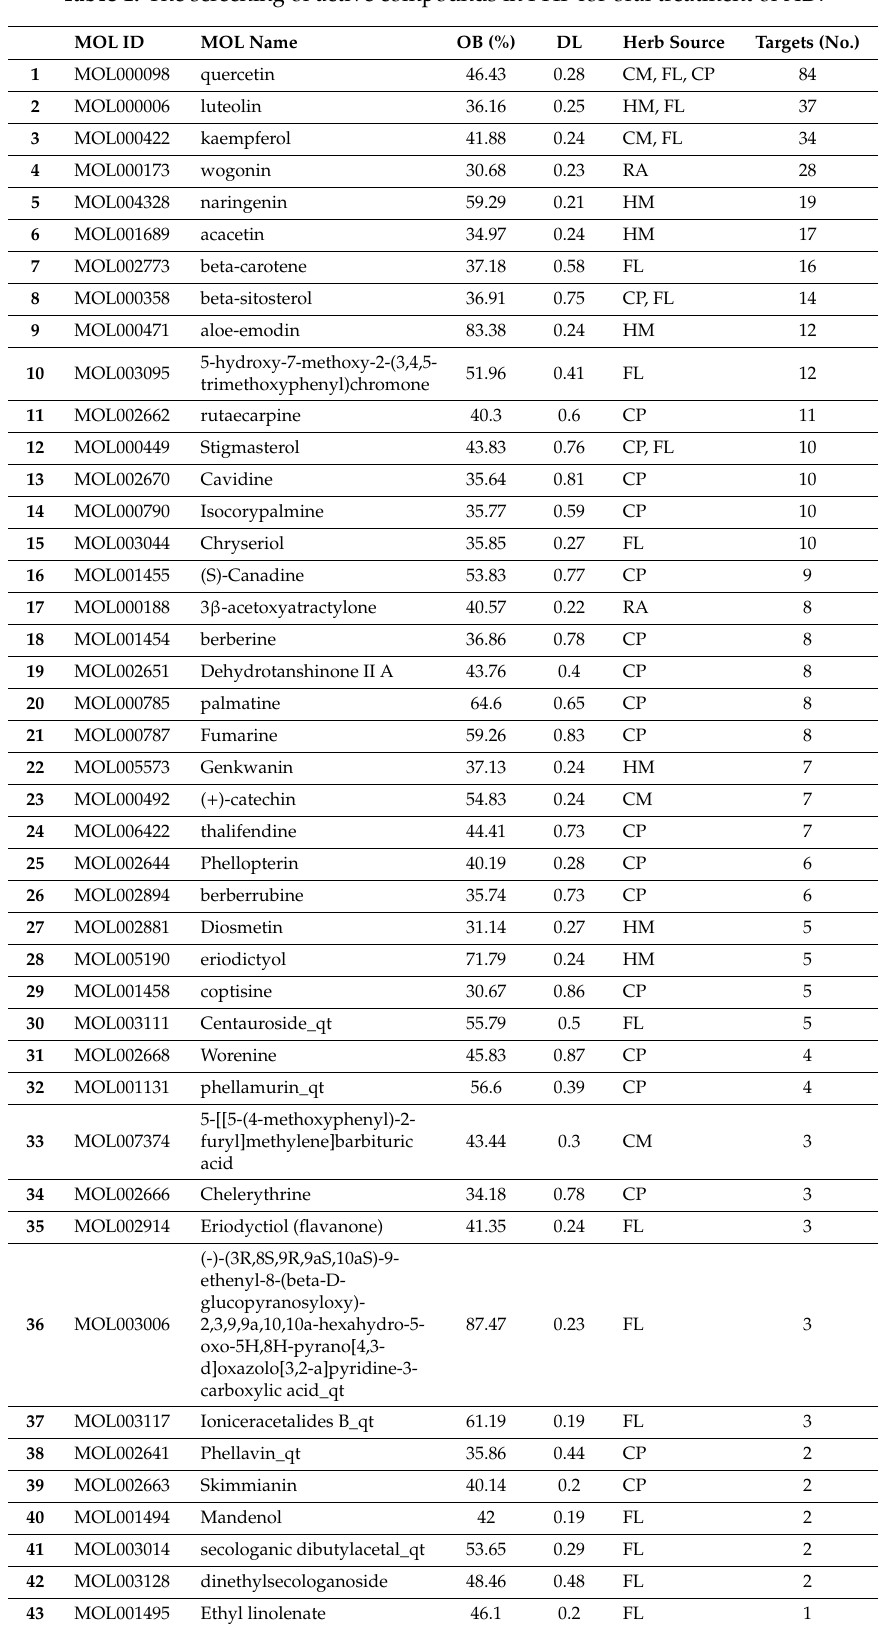
Table 1. The screening of active compounds in PHF for oral treatment of